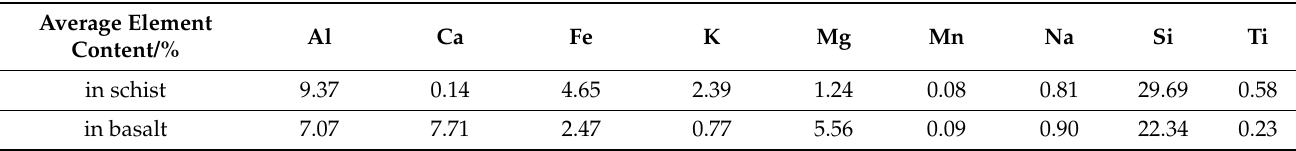
Table 1. Average contents of the elements in the host rocks basalt and schist from the reference analyses.